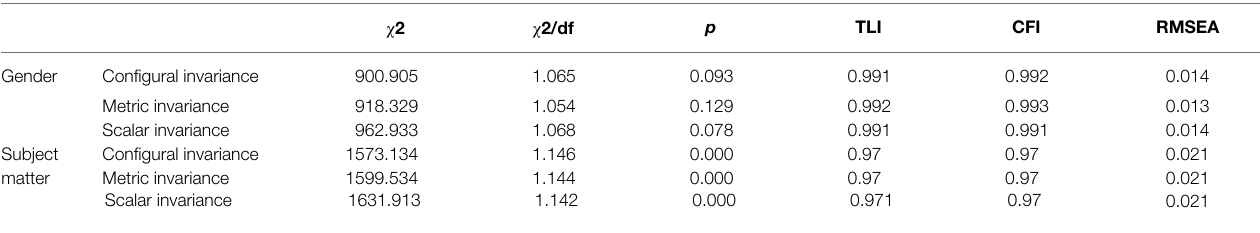
TABLE 4 | Fit indices for invariance